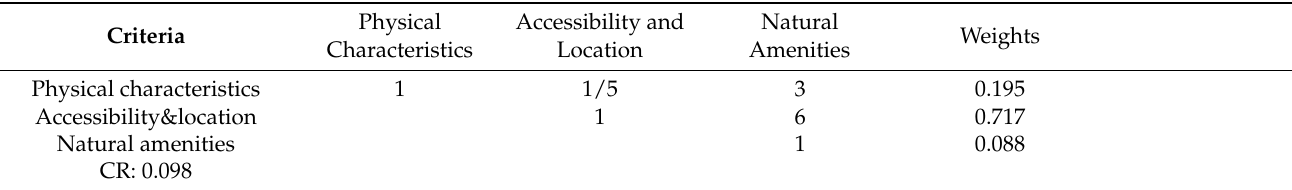
Table A2. Pairwise comparison matrix of the evaluation criteria for residential suitability. Physical Accessibility Criteria Characteristics